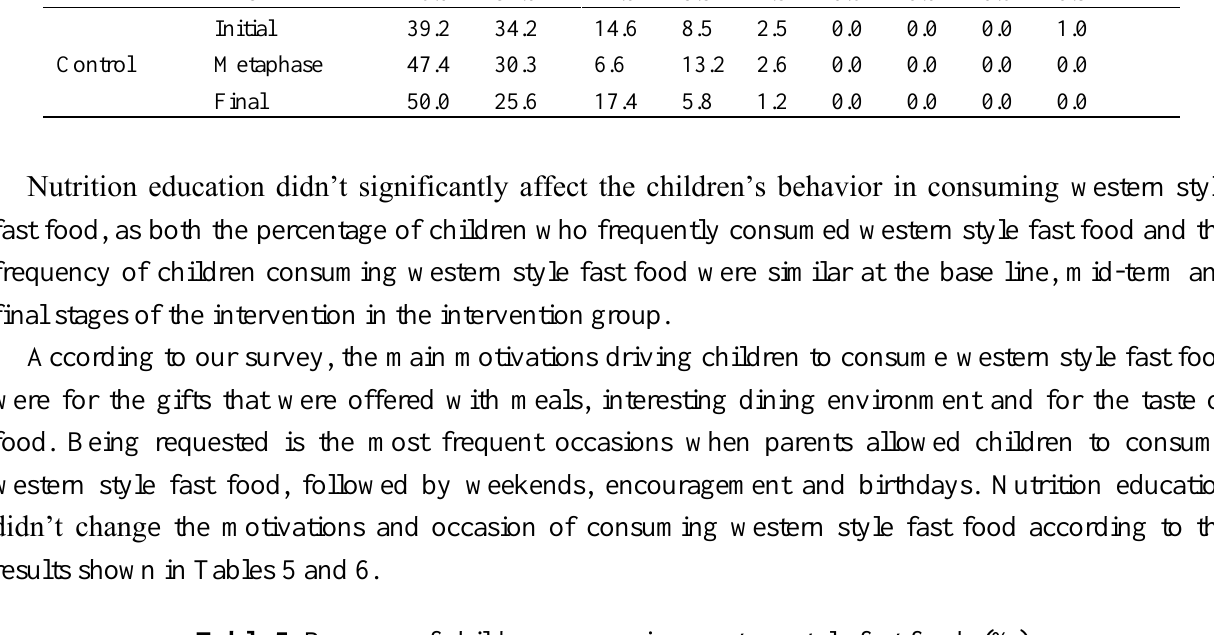
Table 5. Reasons of children consuming western-style fast foods